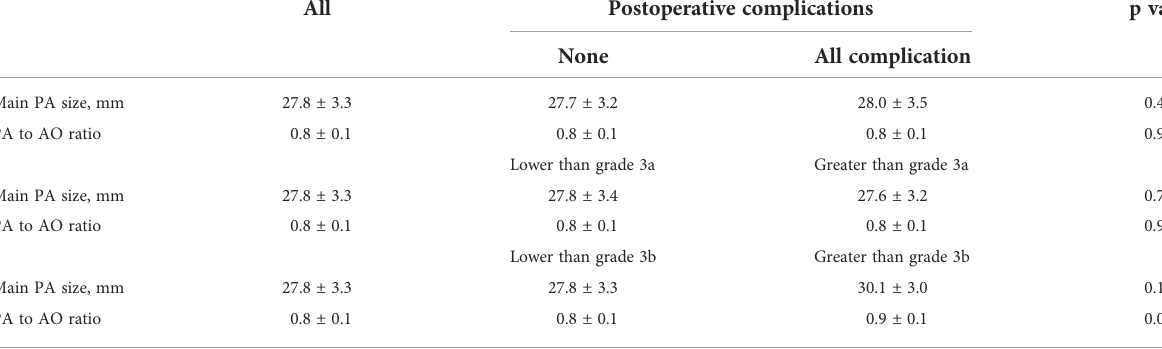
TABLE 4 PA measurements by automated 3D segmentation method relative to postoperative